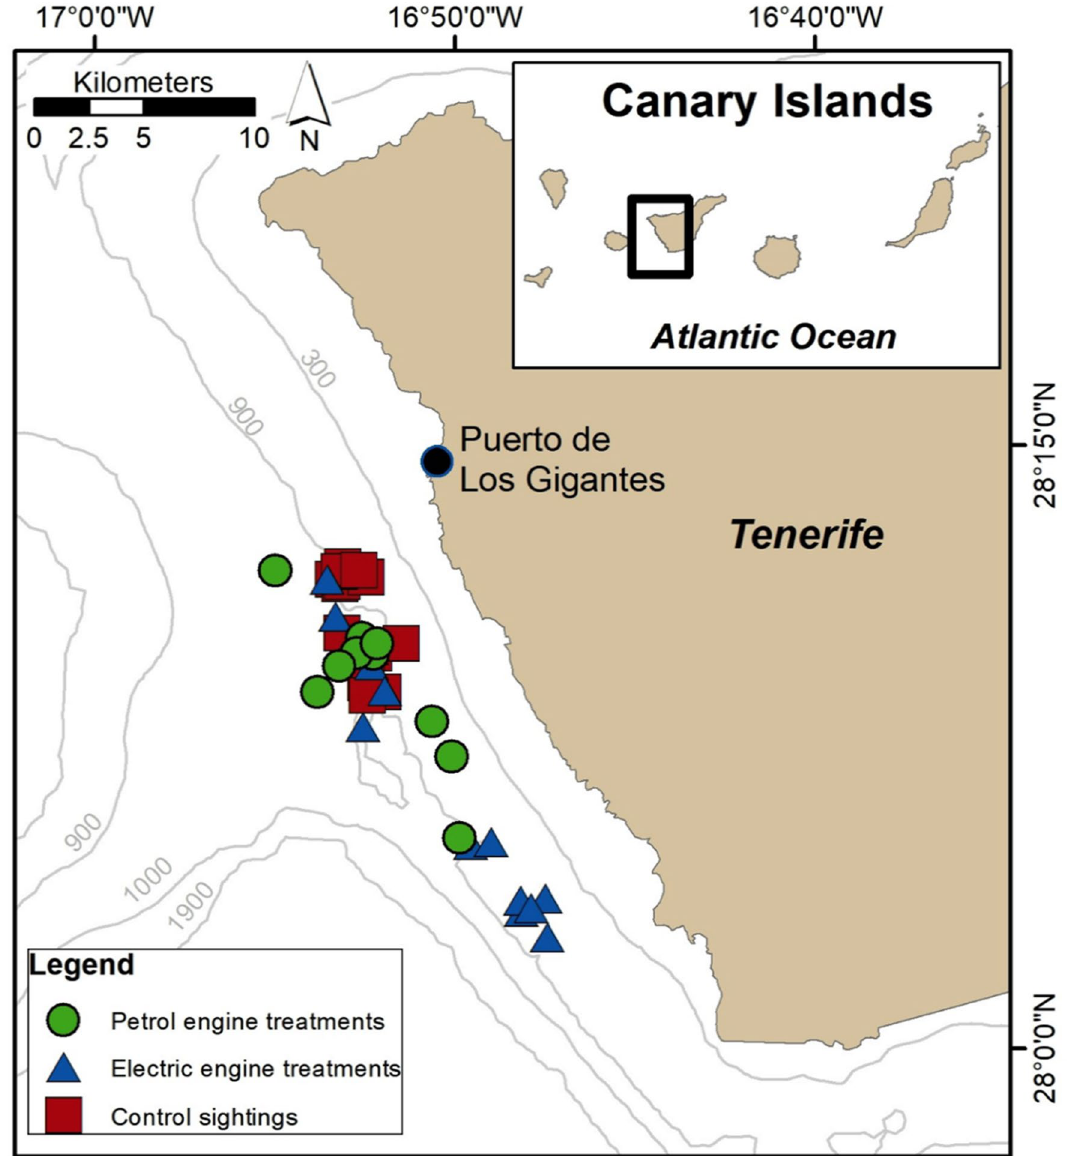
Figure 1. Study area off Tenerife, Canary Islands. Symbols represent control, electric engine and petrol engine treatments. The vessel departed from the Puerto de Los Gigantes marina. Grey lines represent the depth contours of these deep offshore waters (in